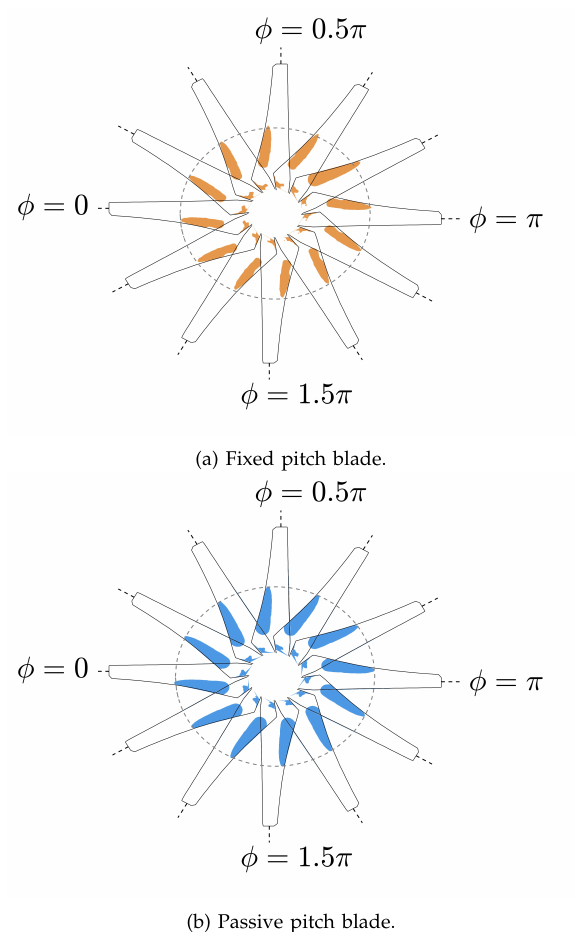
Fig. 12: Suction side of the blade at different azimuthal positions with colored regions of where the tangential wall shear stress is negative and thus the boundary layer is